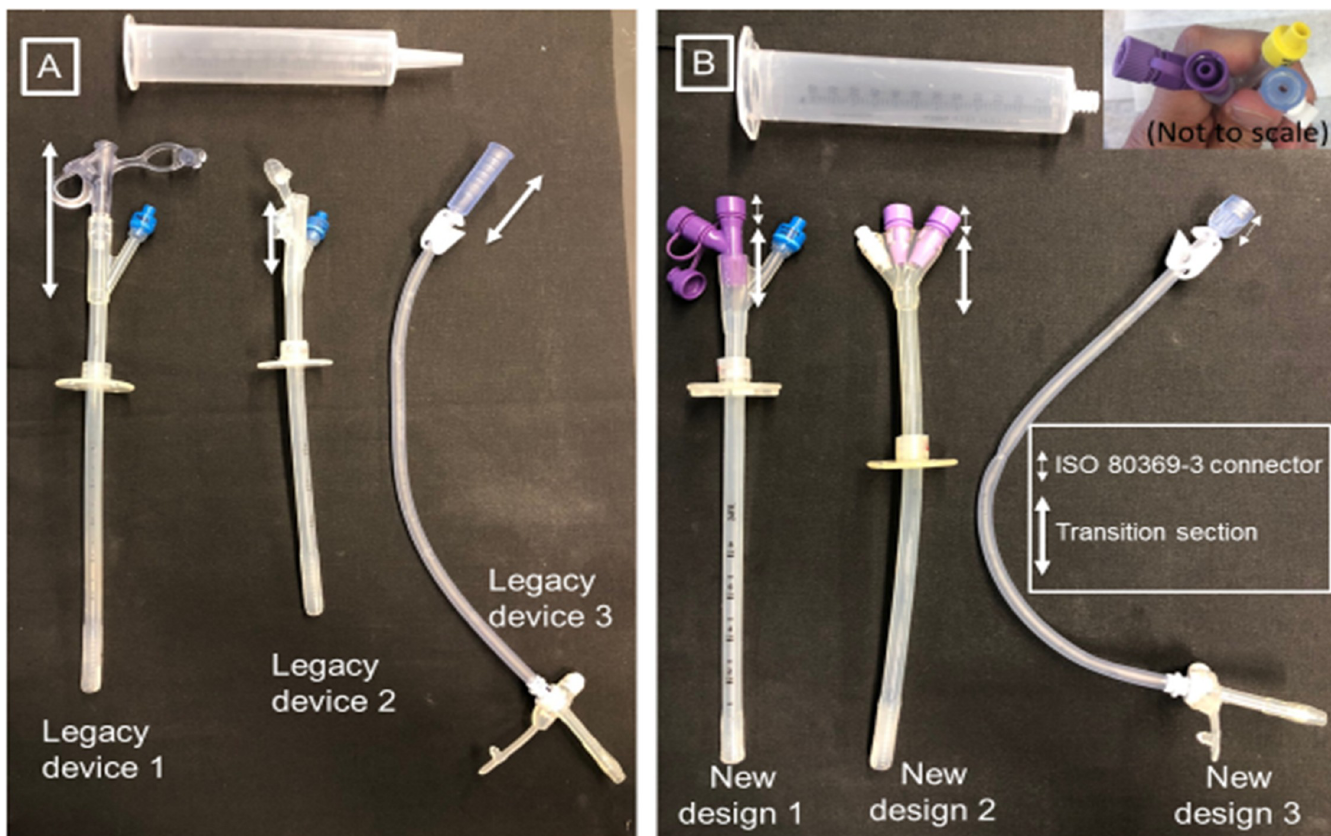
Fig 1. Existing devices and different transition scenarios. (A): A legacy syringe is shown on top with the plunger of the syringe removed. At the bottom are three different legacy G-tubes currently in the U.S. market. All G-tubes have funnel type connectors. (B) An ISO 80369–3 compliant syringe is shown on top with the plunger of the syringe removed. At the bottom are three newer G-tubes with ISO 80369–3 compliant connectors. The inset shows a top view of the ISO 80369–3 compliant connector for two different designs. The numbering of devices in Fig 1 are for explanation purposes only and do not necessarily reflect the devices from our prior study